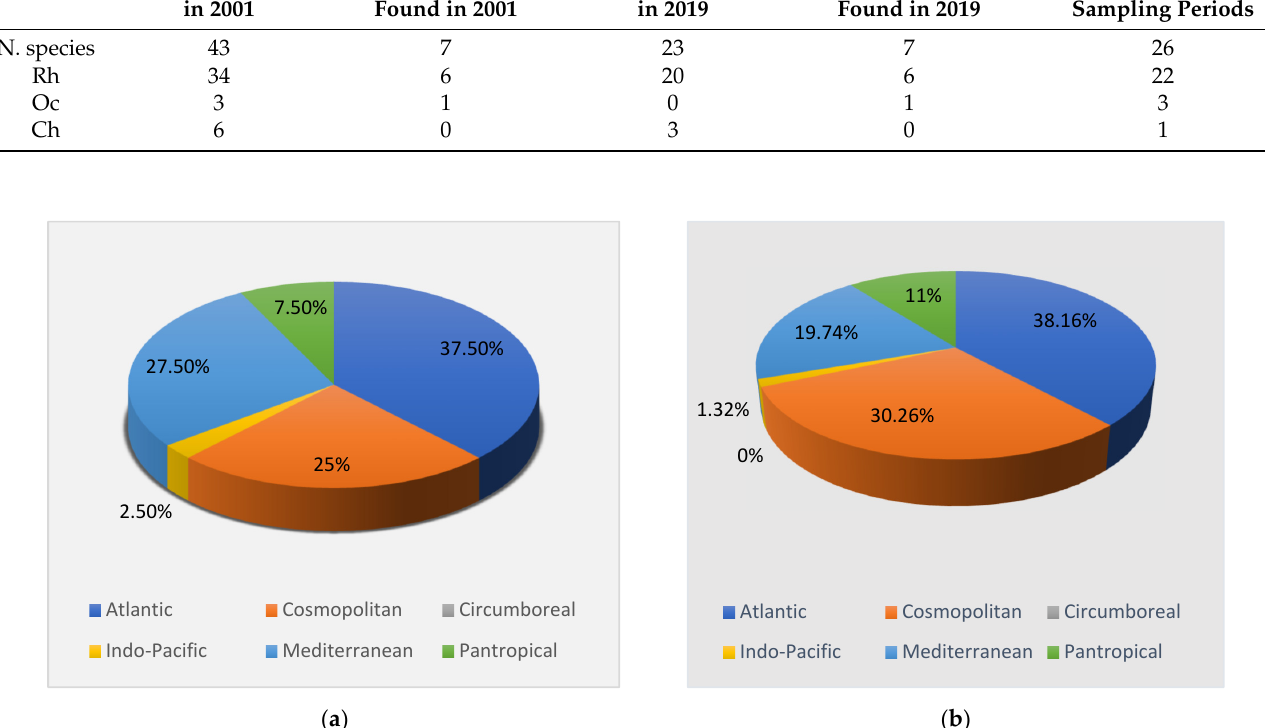
Figure 5. ( a ) Chorology of coralligenous macroalgal assemblages in the 1970s [16,17]; ( b ) Chorology of coralligenous macroalgal assemblages in 2001 [18].